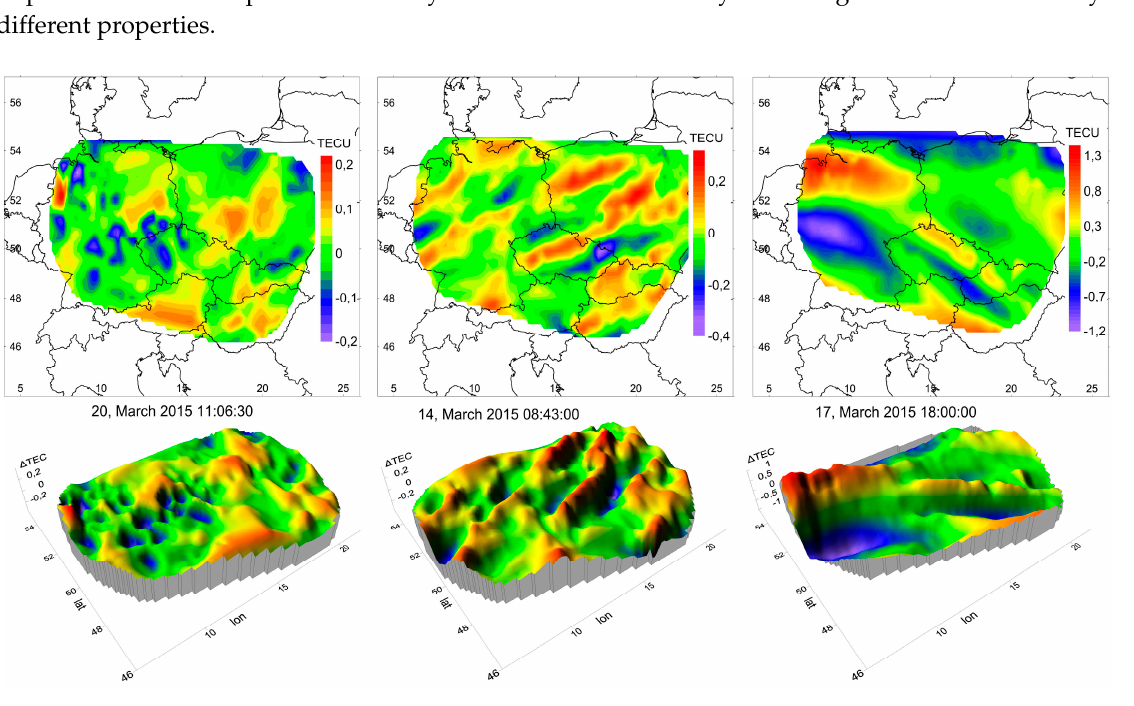
Figure 4. Representative examples of TEC variation spatial distribution.